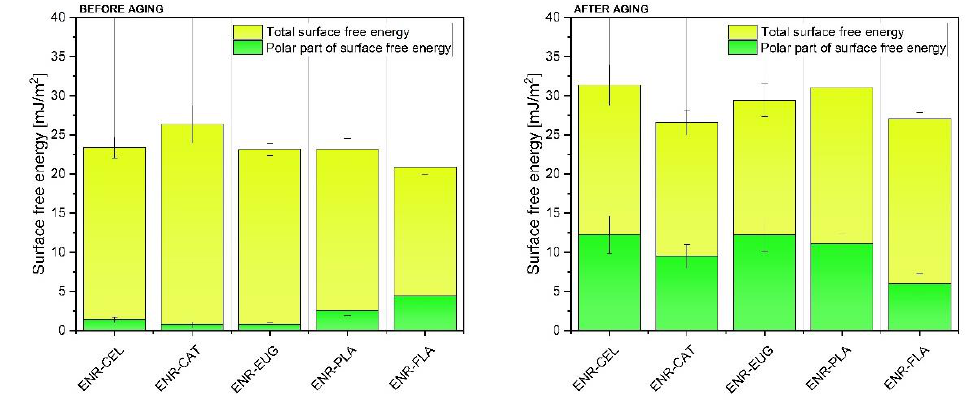
Figure 8. Surface free energy of ENR samples before and after aging. The ENR–CAT sample presented distinct properties compared with other